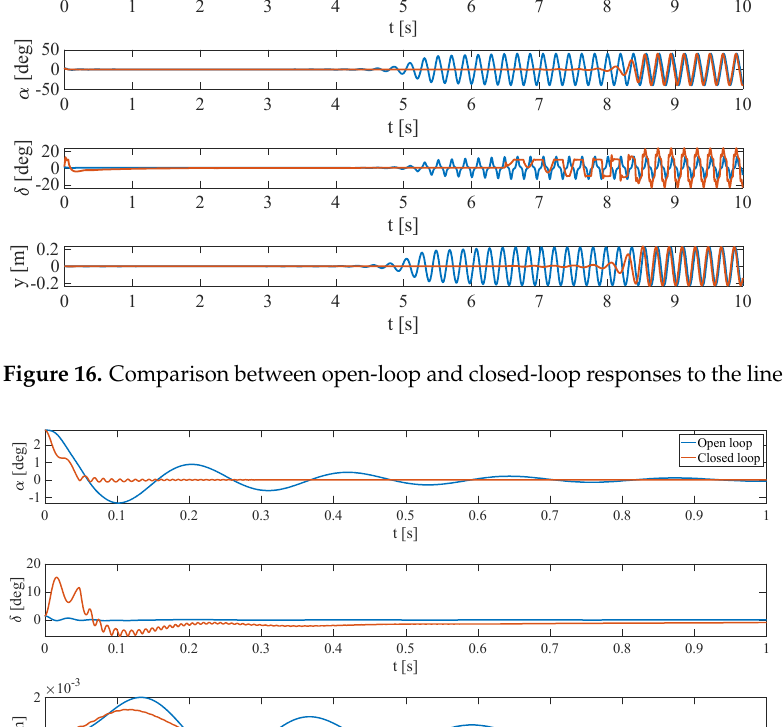
. Thus, it was (cid:3046) to 28 (cid:3040) with different acceleration (cid:3046) (cid:3046)